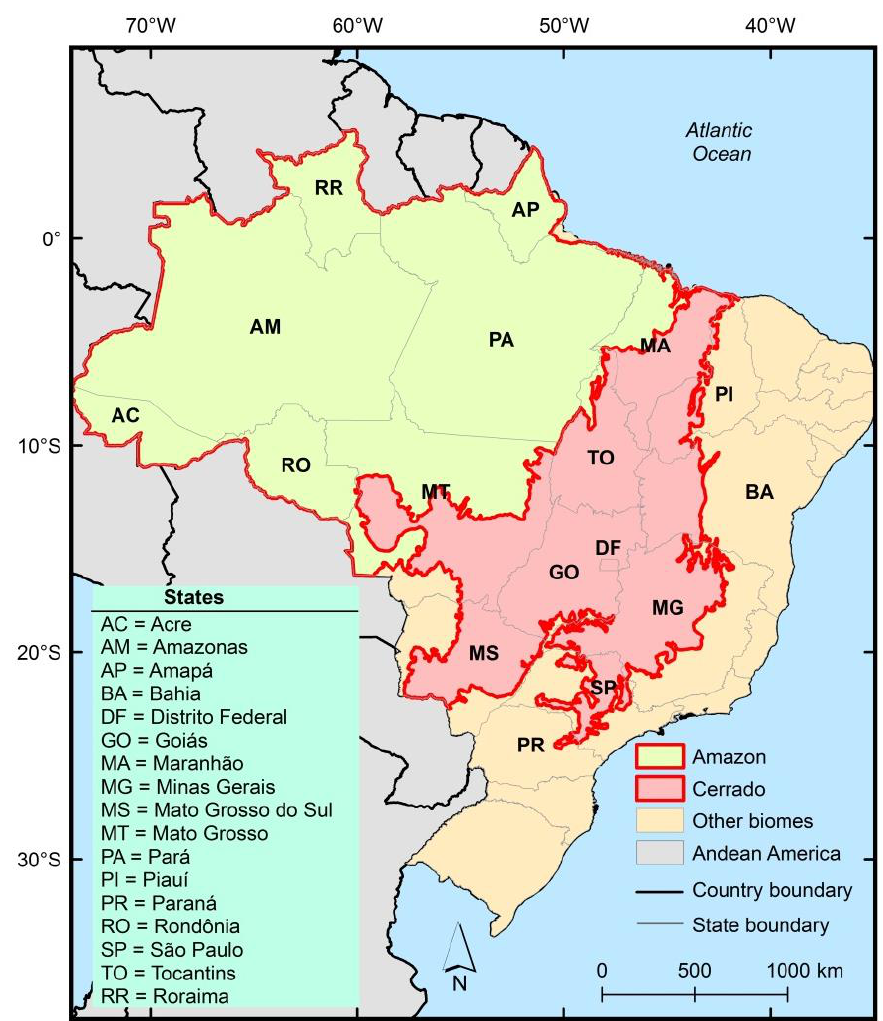
Figure 1. Location of the study areas (Amazon and Cerrado biomes) in the northern and central parts of Brazil. Amazon biome corresponds to the tropical rainfall forest and Cerrado biome corresponds to the tropical savannah. “Other biomes” in the legend correspond to the Caatinga (semi-arid), Atlantic Forest (coastal forest), Pampa (grasslands), and Pantanal (wetlands) (boundaries not shown in the figure). Source: [27].